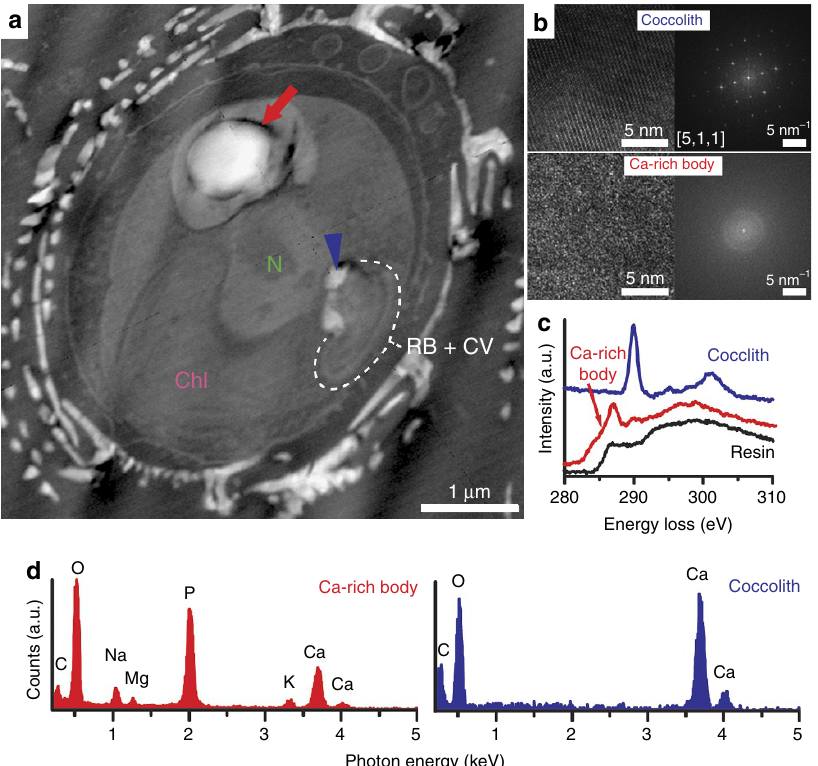
Figure 4 | Ultrastructural and elemental microanalysis of the calcium-rich body. ( a ) HAADF-STEM image of a thin-sectioned cell showing the nucleus (N), the chloroplast (Chl), the coccolith vesicle (CV)–reticular body system (RB) (encircled by the white line), coccolith calcite (blue arrowhead) and the Ca-rich body (red arrow). Additional organelles that are visible in the HAADF-STEM images are shown in Supplementary Fig. 4. ( b ) High-resolution images and corresponding Fourier-transformed image of coccolith calcite and the Ca-rich body. ( c ) STEM-EELS spectra measured at the carbon K-edge on the Ca-rich body, coccolith calcite and embedding resin. ( d ) STEM-EDX spectra of the Ca-rich body and coccolith calcite.